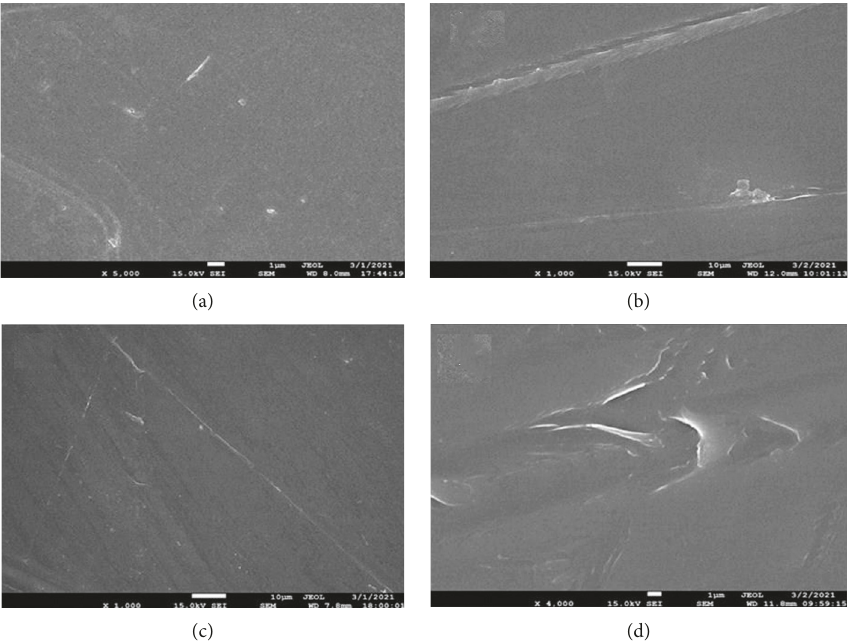
Figure 2: Surface morphology of the F3 (a and b) and F4 (c and d) films.